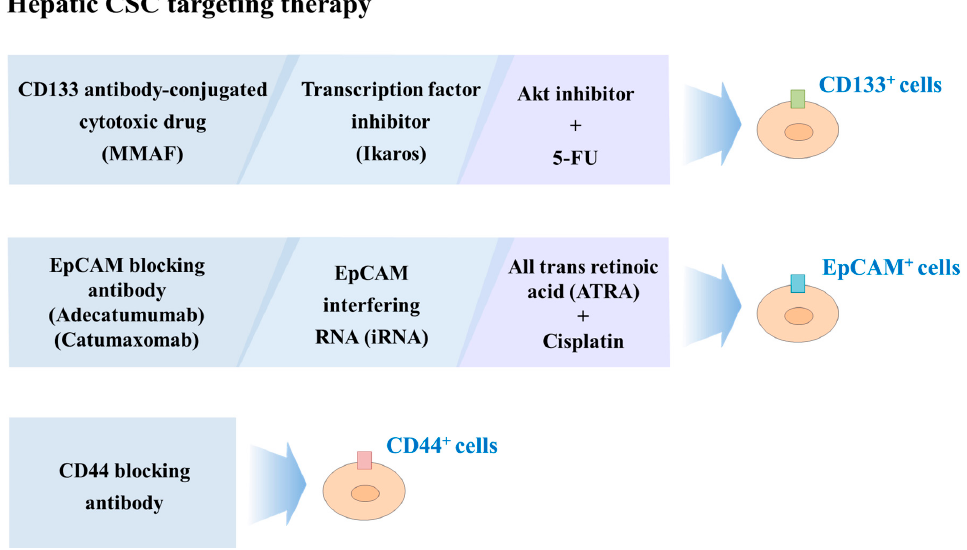
Figure 4. Schematic diagram summarizing the effect of target therapy on hepatic CSCs. CD133 antibody conjugated to a cytotoxic drug (monomethyl auristatin F), transcription factor inhibitor Ikaros, and Akt signaling inhibitor with 5-FU reduced the self-renewal capacity of CD133+ hepatic CSCs. All-trans retinoic acid (ATRA) with cisplatin, Oncostatin M (OSM), EpCAM-blocking antibodies (Adecatumumab and Catumaxomab), and EpCAM blocking RNA interference (RNAi) inhibited the self-renewal capacity of CD133 + hepatic CSCs. In addition, anti-CD44 antibody prevented the tumor formation and metastasis of CD44-positive hepatic CSCs.